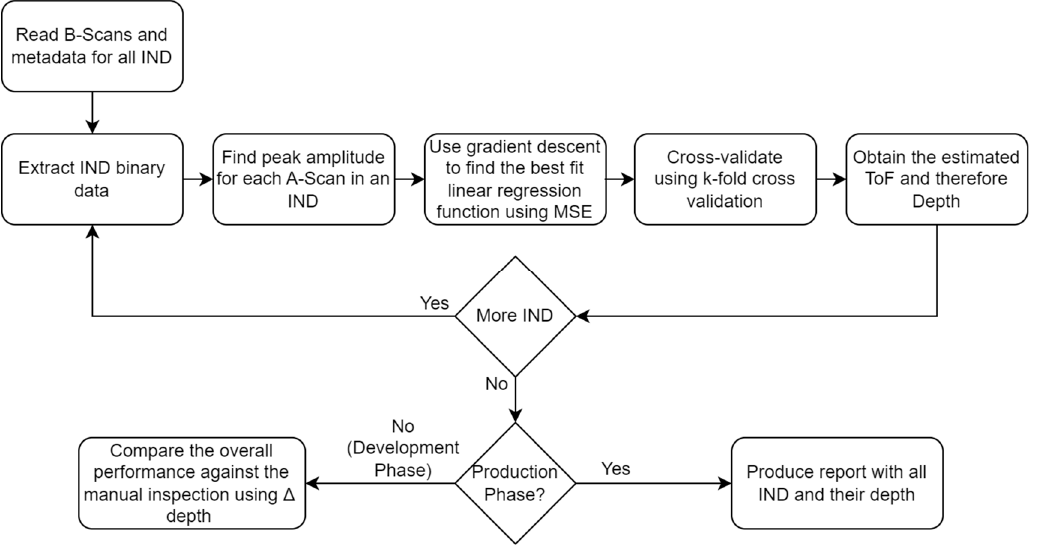
Figure 6. Segmented linear regression algorithm structure.